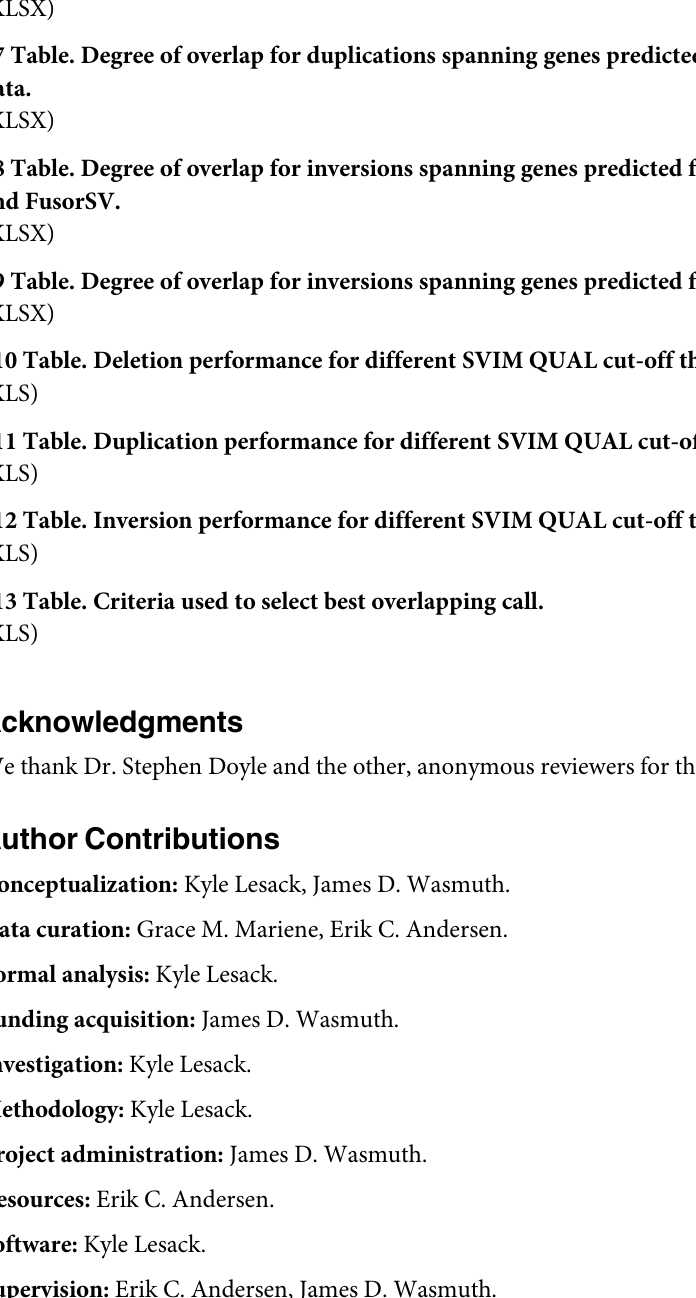
S5 Table. Degree of overlap for deletions spanning genes predicted from short-read data. S6 Table. Degree of overlap for duplications spanning genes predicted from long-read data and FusorSV. S7 Table. Degree of overlap for duplications spanning genes predicted from short-read data. S8 Table. Degree of overlap for inversions spanning genes predicted from long-read data and FusorSV. S9 Table. Degree of overlap for inversions spanning genes predicted from short-read data. S10 Table. Deletion performance for different SVIM QUAL cut-off thresholds. S11 Table. Duplication performance for different SVIM QUAL cut-off thresholds. S12 Table. Inversion performance for different SVIM QUAL cut-off thresholds. (XLS) S13 Table. Criteria used to select best overlapping